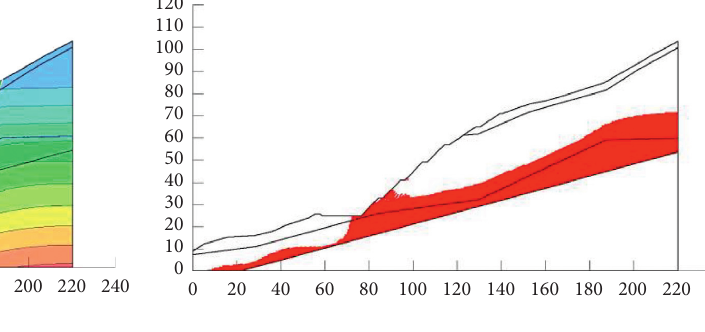
Pore-water pressure